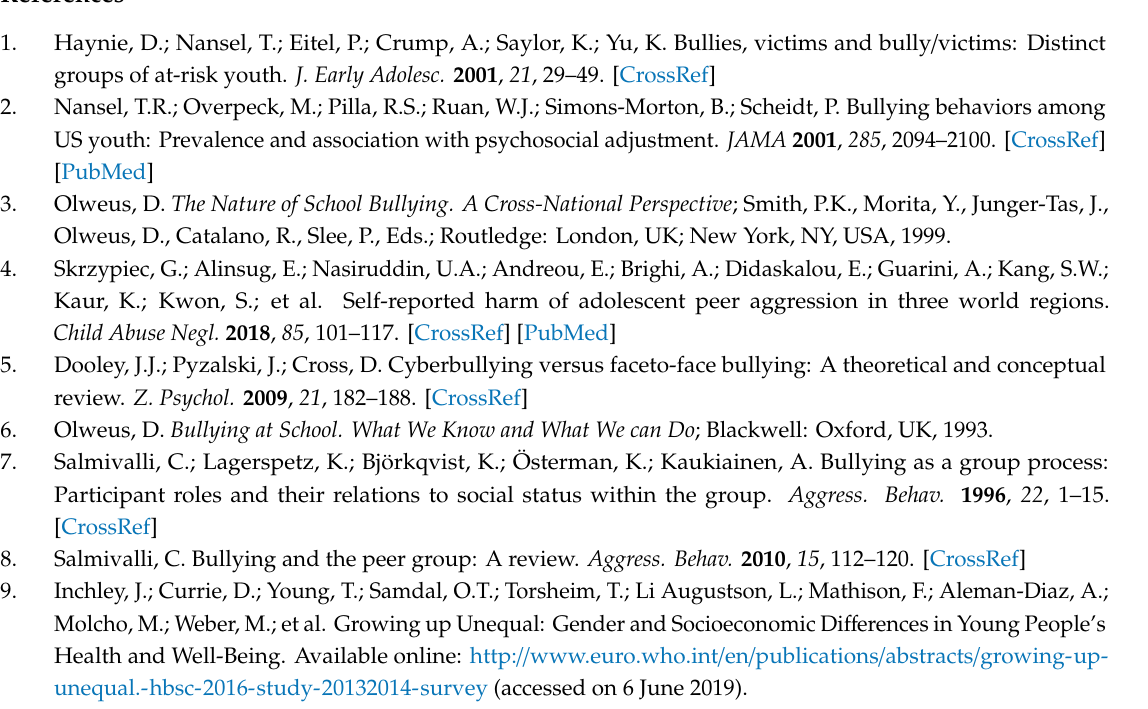
Table S1: Search